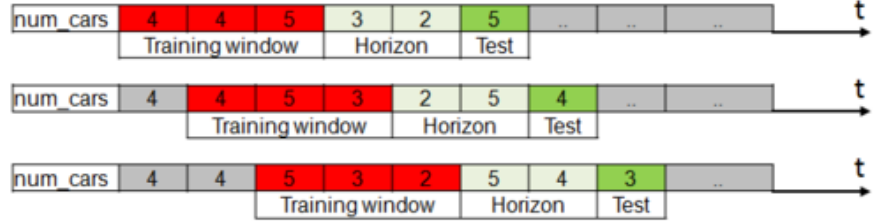
Figure 4. Window-based model; Training window size TW size = 3; Prediction horizon δ =